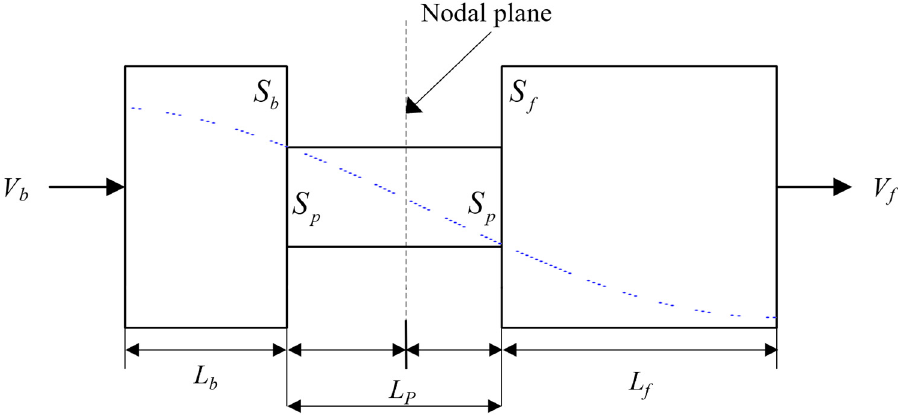
Figure 2. Schematic diagram of standing waves in a simplified sandwich transducer.